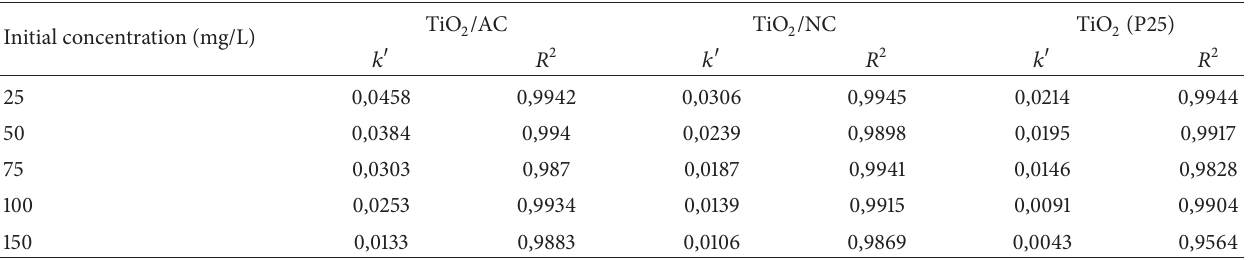
Table 2: Degradation reaction rate constants by UV irradiation photocatalytic oxidation of MG dye over TiO 2 /AC, TiO 2 /NC, and TiO 2 (P25). Initial concentration (mg/L)